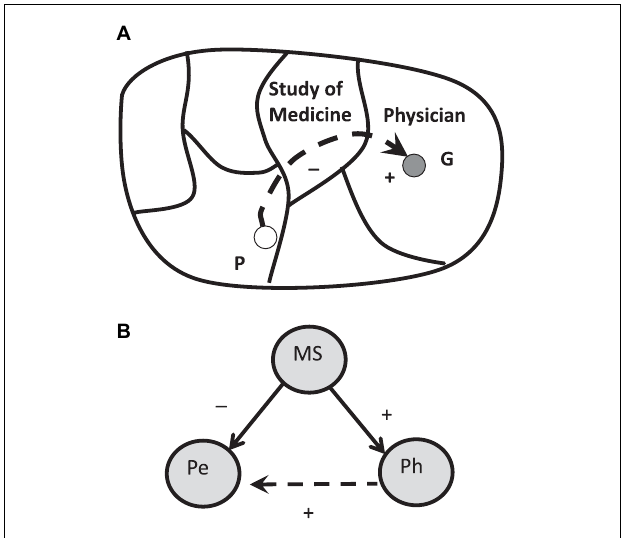
FIGURE 5 | The structure of the life space with the topological location of the person (P, Pe) and the intended goal (G, physician), that has a high valence for the person to achieve, but some fields are barriers and puffer the goal area. For instance, to become a doctor, one has to pass the time-consuming barrier of the medicine study (Lewin, 1951). Topology (A) and network representation (B)